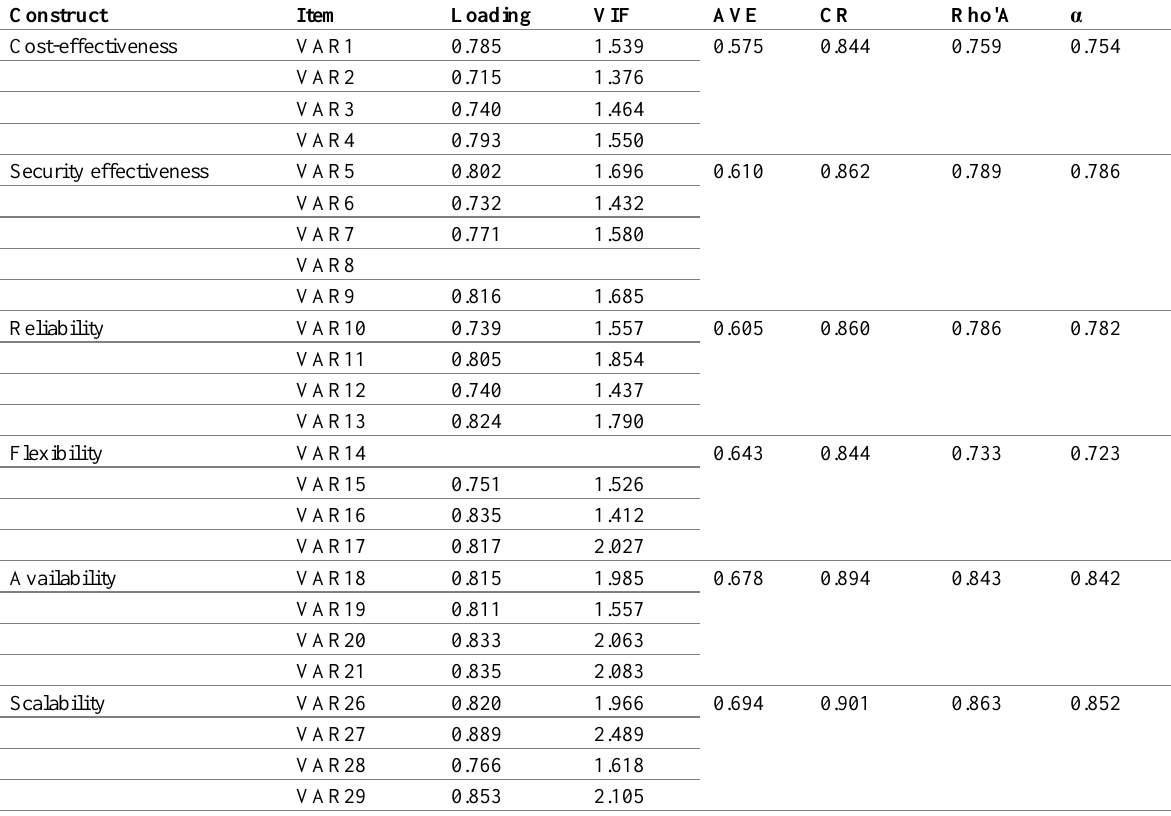
Table 3: Validity and Reliability of the Constructs